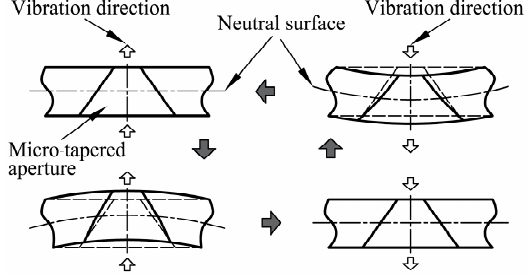
Figure 3. Illustrative diagram of the dynamic cone angle.